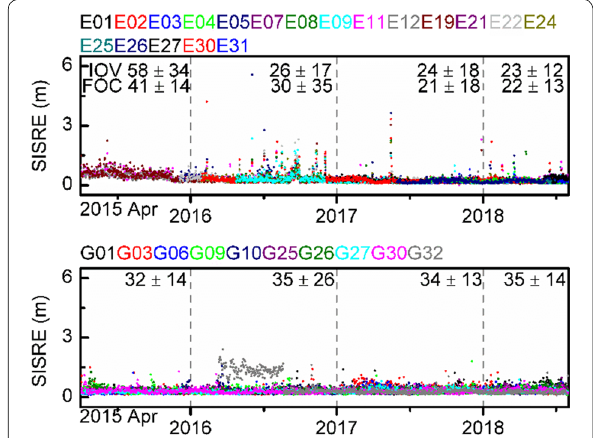
Fig. 9 Time series of Galileo FNAV ( top ) and GPS IIF LNAV ( bottom ) global average SISRE errors and annual statistics of mean and STD (cm)